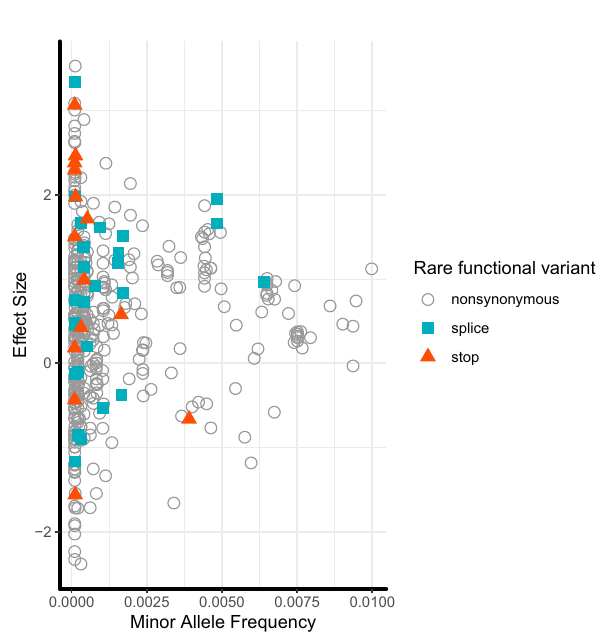
Gene symbols are shown italicized. The same signi fi cance threshold for the burden and SKAT tests was chosen (two-sided test). mGWAS GWAS of the respective metabolites, SE standard error.